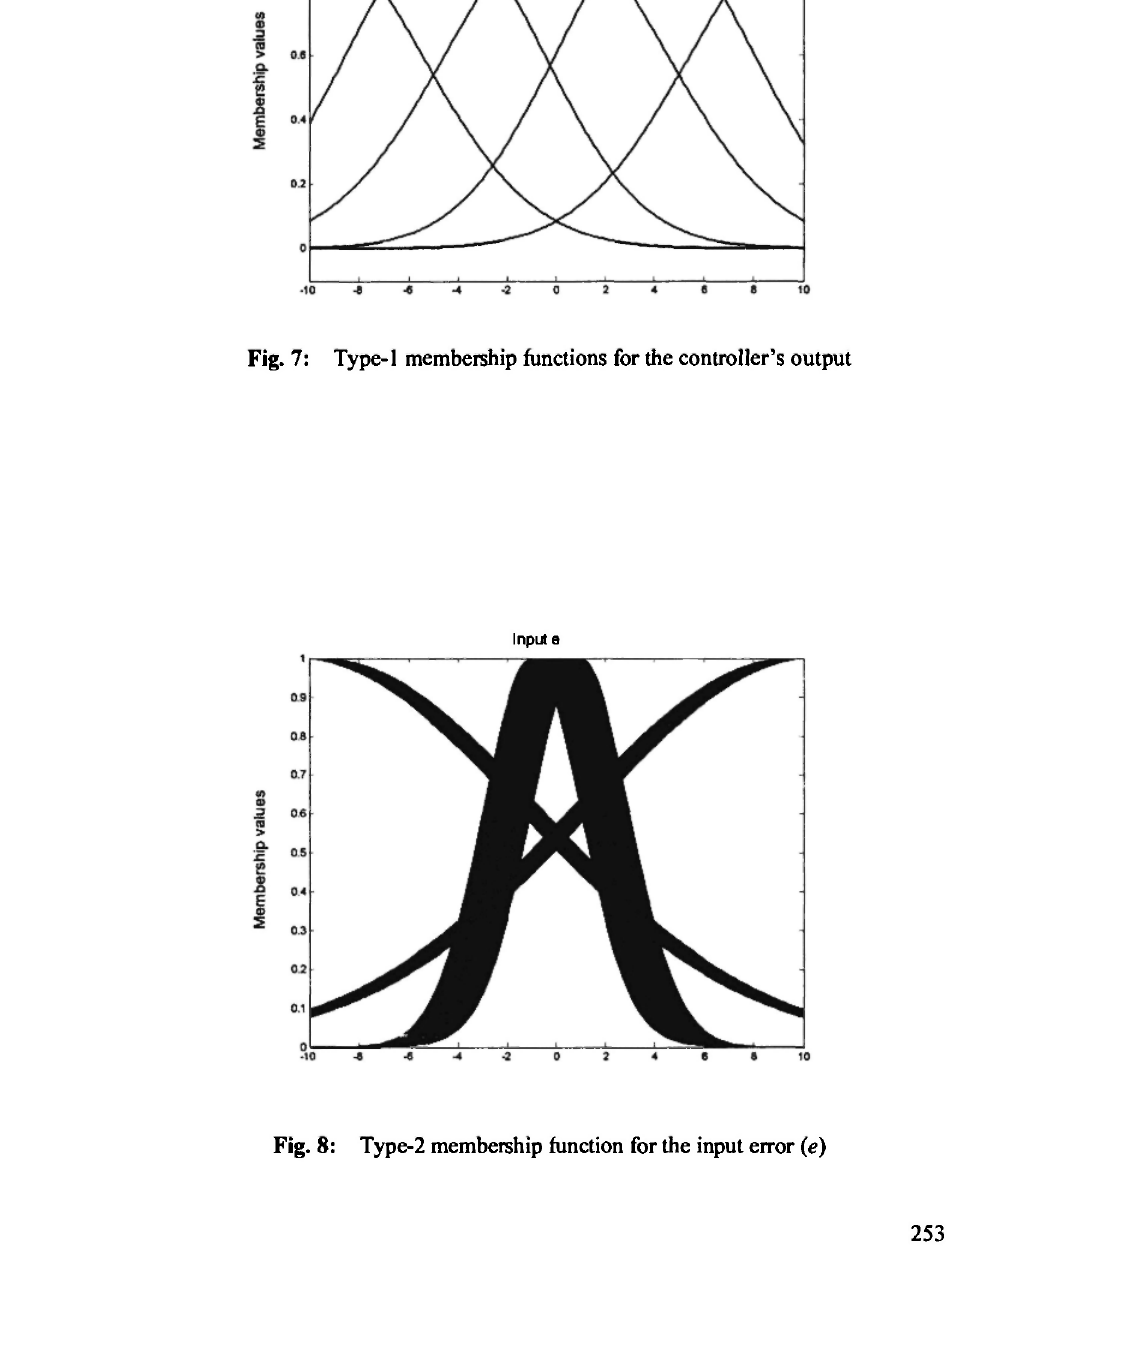
Fig. 7: Type-1 membership functions for the controller's output